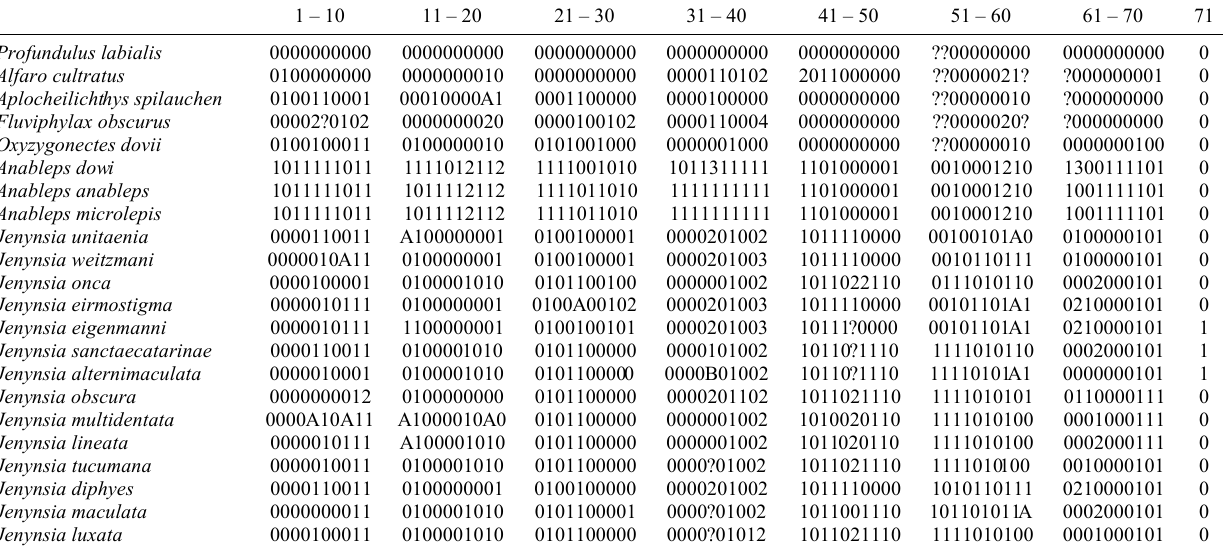
Table 2. Morphological data matrix. A= polymorphic character, states 0 and 1; B= polymorphic character, states 0 and 2; ?= missing